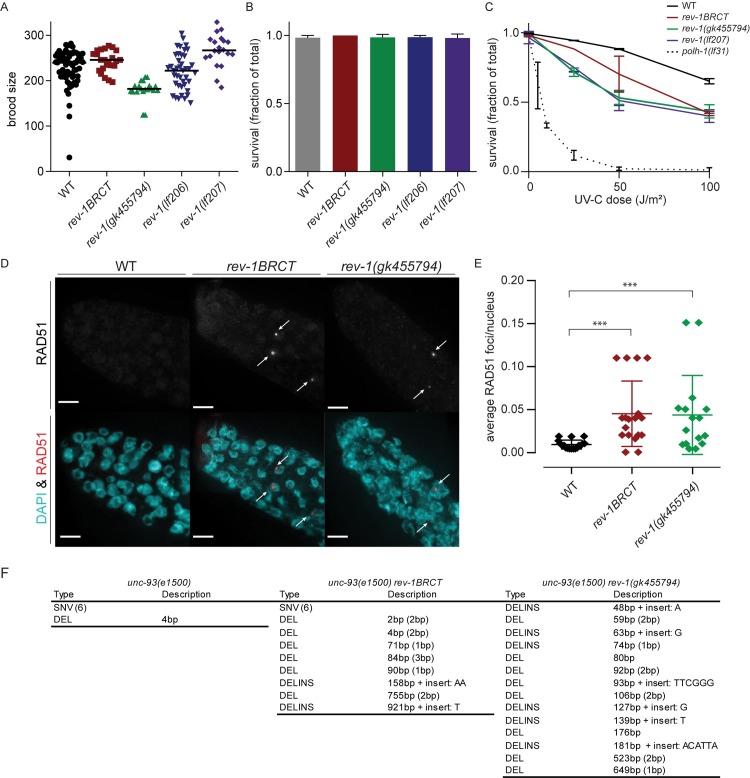
Spontaneous DNA damage and mutagenesis in rev-1 deficient animals.A) Quantification of total brood sizes for different rev-1 alleles. Each data point represents the total brood of a single hermaphrodite. B) The surviving fraction of progeny was calculated as the number of hatched eggs divided by the brood size. Error bars denote SD. C) Progeny survival in response to UV-C exposure to hermaphrodites of the indicated genotype. Error bars denote SEM. D) Representative images of RAD-51 and DAPI-stained distal tips of C. elegans gonads. Arrows point to RAD-51 foci. E) Quantification of spontaneous RAD-51 foci in the mitotic compartment of the gonadal arms. Each dot represents the average number for a single mitotic region. Error bars indicate mean with sd (*** indicates p<0.001, t-test). F) Molecular descriptions of the mutations found in unc-93 for the indicated genotype (SNV = single-nucleotide variation, DEL = deletion, DELINS = deletion with insert). The number of SNVs found is indicated between parentheses. The degree of micro-homology found at deletion junctions is indicated between parentheses. For rev-1 deficient animals 30 revertants were analyzed. Data from REV-1 proficient unc-93 reversion is retrieved from [13].